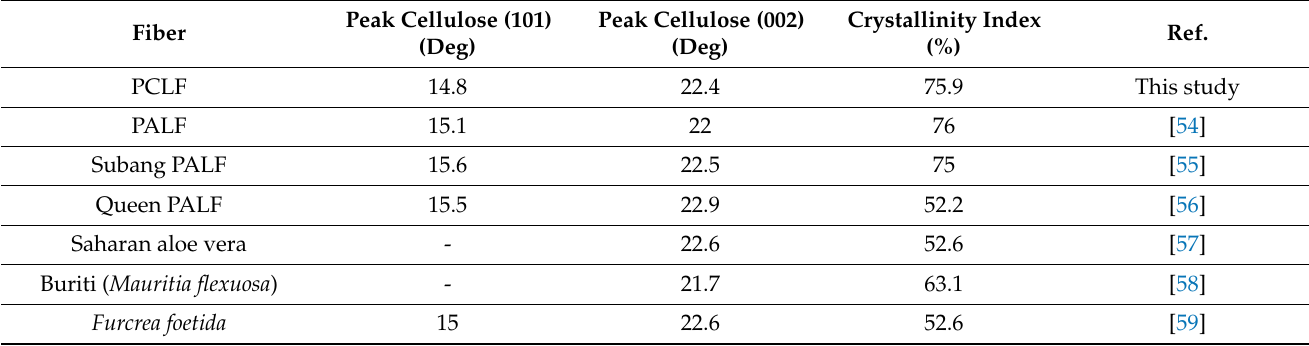
Table 3. Cellulose peaks and crystalline index as from XRD for different fibers (including PCLF).